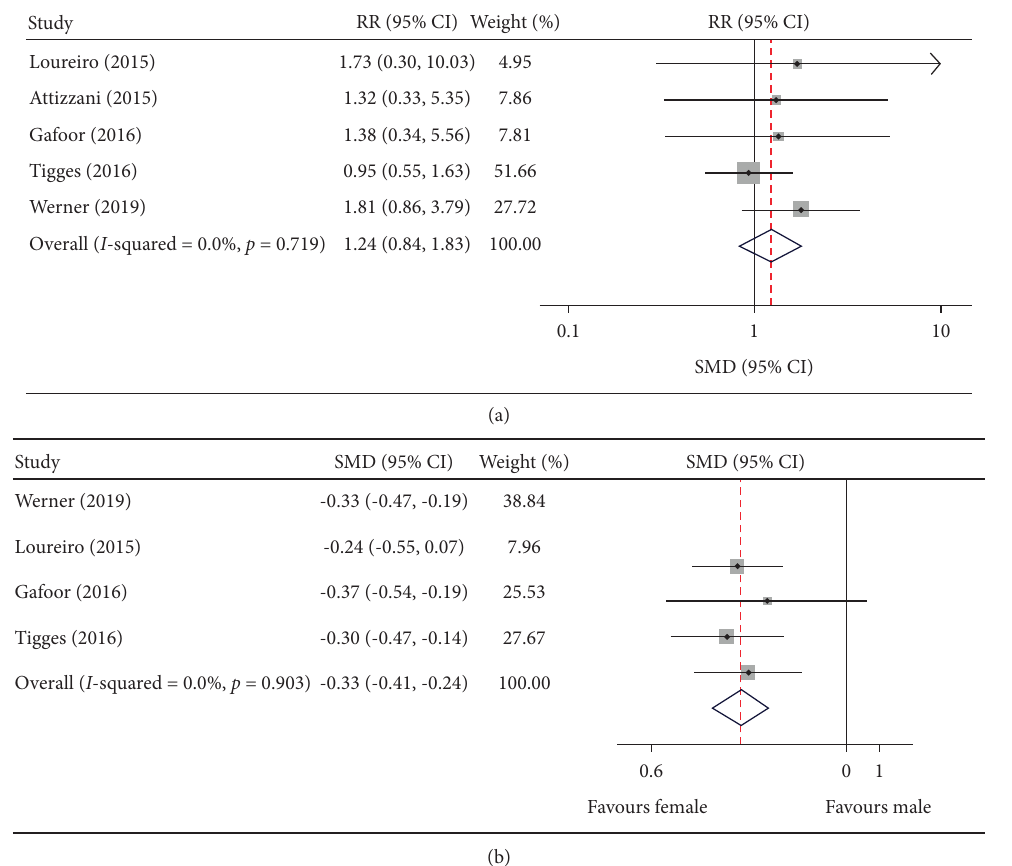
Figure 4: Male versus female. (a) Risk ratio and 95% CI for the comparison of procedure failure. (b) MD and 95%CI for the pooled endpoint of number of clips